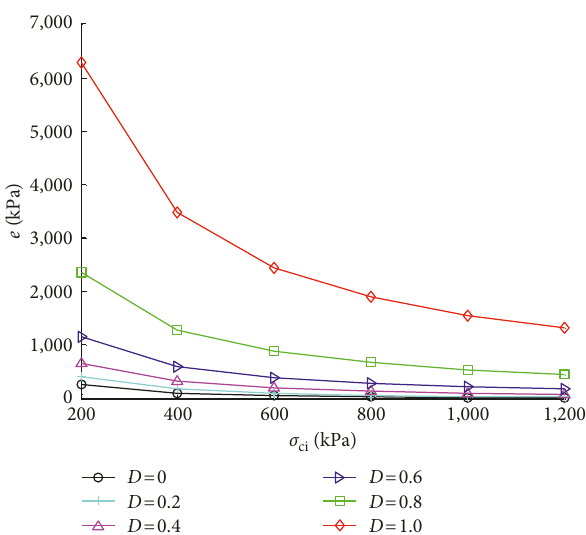
Figure 11: Effect of σ